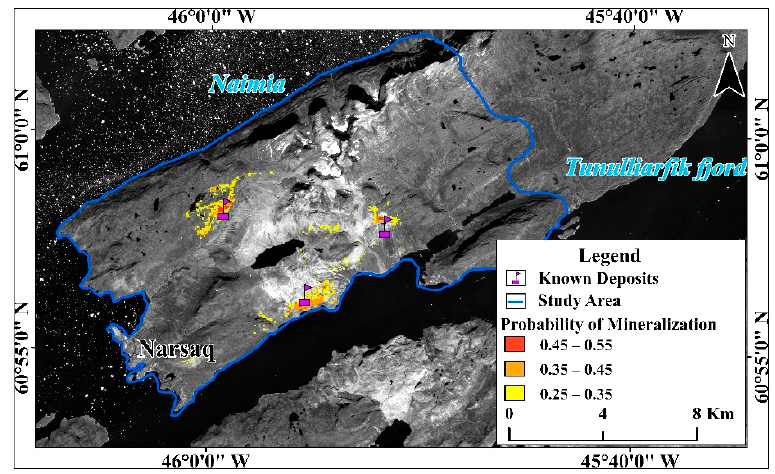
Figure 15. Map of projected potential mineralization areas (the base image was made using the Sentinel-2 panchromatic band).